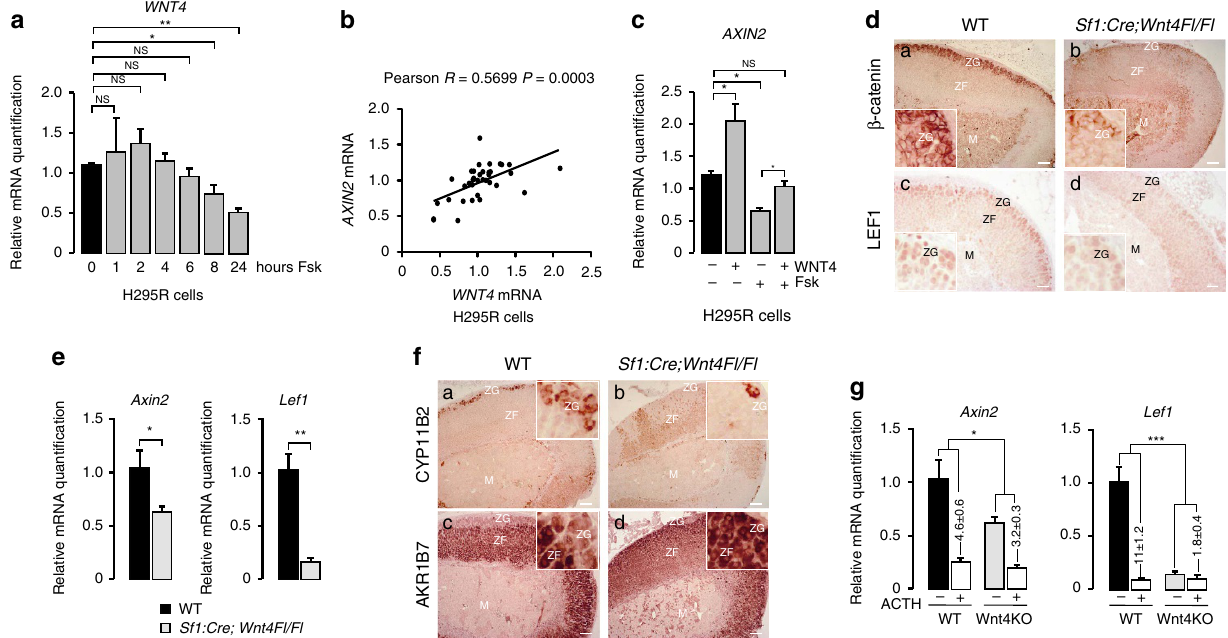
Figure 4 | WNT4 repression mediates the effect of PKA on WNT signalling in the adrenal gland. ( a ) Forskolin represses WNT4 expression in human adrenocortical H295R cells. Human H295R cells were treated with either vehicle (0) or Forskolin 10 (cid:2) 5 M (Fsk) for 1 to 24 h and WNT4 expression was analysed by RTqPCR. Bars represent mean expression in three independent experiments (in triplicate) ± s.e.m. ( b ) AXIN2 and WNT4 expression levels are correlated in H295R cells. AXIN2 and WNT4 expression levels were correlated on the basis of RTqPCR data generated from H295R cell treatments. ( c ) Overexpression of WNT4 reverses the effect of Forskolin on AXIN2 expression. H295R cells were transfected with pCMV-WNT4 to induce overexpression of WNT4 and treated with DMSO or Forskolin 10 (cid:2) 5 M (Fsk) for 8h. Expression of AXIN2 was determined by RTqPCR. Bars represent mean expression in three independent experiments ± s.e.m. Statistical analyses were performed by one-way ANOVA followed by Tukey’s post-hoc test ( d ) Wnt4 genetic ablation inhibits WNT pathway activation in ZG. Expression of b -catenin and WNT pathway target LEF1 was analysed by immunohistochemistry in the adrenals from wild-type and Sf1:Cre;Wnt4Fl/Fl mice . ( e ) Wnt4 genetic ablation is associated with decreased Axin2 and Lef1 expression in the adrenal. Axin2 and Lef1 expression levels were analysed by RTqPCR on mRNAs extracted from wild-type and Sf1:Cre;Wnt4Fl/Fl adrenals. Bars represent the mean expression in 5 animals per group ± s.e.m. Statistical analyses were performed by Student’s t test. ( f ) Wnt4 genetic ablation is associated with loss of ZG differentiation and expansion of ZF. Expression of CYP11B2 (ZG) and AKR1B7 (ZF) was analysed in the adrenals from wild-type and Sf1:Cre;Wnt4Fl/Fl mice. ( g ) The ability of ACTH to repress Axin2 and Lef1 expression is blunted in Wnt4 knockout adrenals. Wild-type and Sf1:Cre;Wnt4Fl/Fl mice were treated for three days with PBS or ACTH (Synacthene Retard) and Axin2 and Lef1 expression levels were evaluated by RTqPCR. Bars represent the mean expression in 5 adrenals per genotype and per treatment group ± s.e.m. Fold repression by ACTH over PBS in both wild-type and Sf1:Cre;Wnt4Fl/Fl mice is